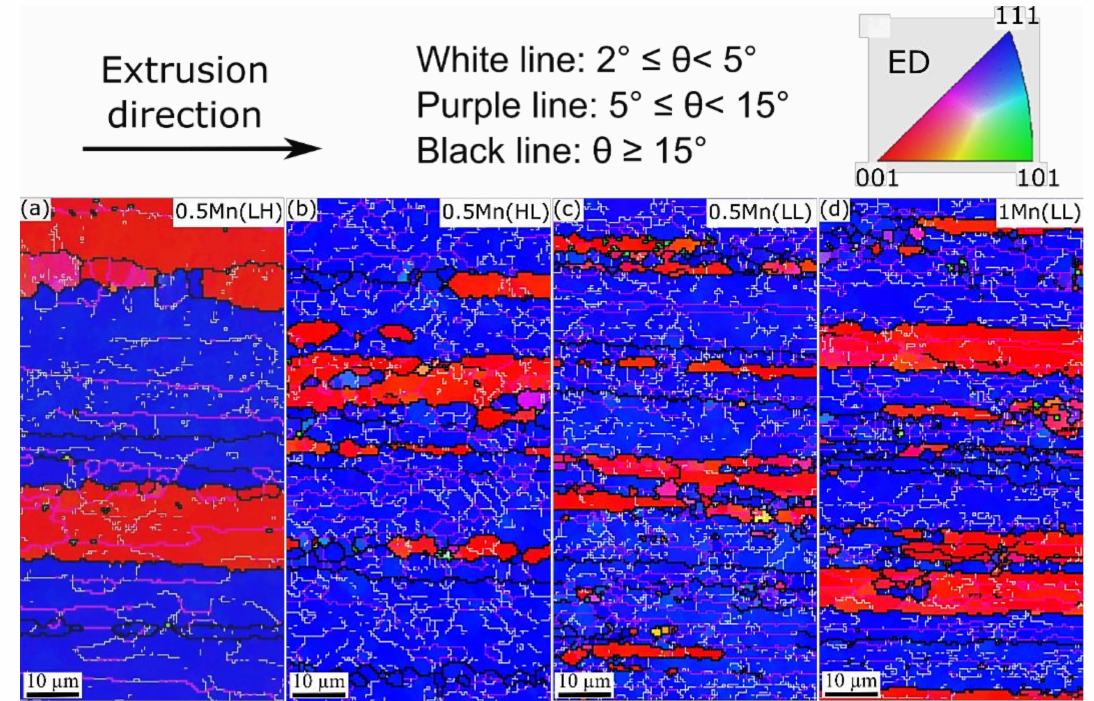
Figure 2. EBSD inverse pole figure (IPF) maps of as-extruded ( a ) 0.5Mn(LH), ( b ) 0.5Mn(HL), ( c ) 0.5Mn(LL), and ( d ) 1Mn(LL), showing the grain and subgrain structures at the center of the extruded rods, and the crystallographic orientations of grains along the